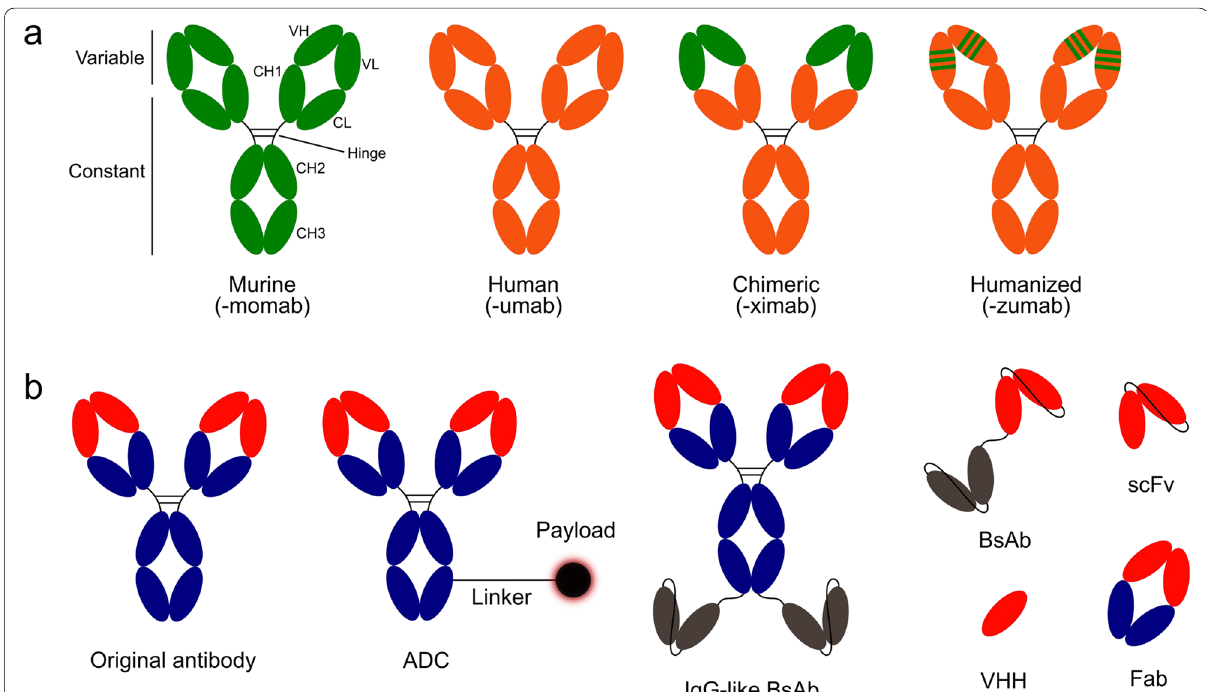
Fig. 5 Schematic overview of mAb, ADC, BsAb, and antibody fragments (Fab, scFv, VHH). a Antibody humanization from the murine antibody (green domain) to human antibody (orange domain) and associated suffixes. The chimeric mAb: the variable region is of murine origin, and the rest of the chain is of human origin. Humanized mAb: only includes the hypervariable segment of murine origin. CH: domains of the constant region of the heavy chain; CL: constant domain of the light chain; VH: variable domain of the heavy chain; VL: variable domain of the light chain. b Original antibody includes variable regions, also called VH and VL (red domain), and the constant region (blue domain). ADC comprises a mAb connected to a cytotoxic payload via an appropriate linker. BsAb consists of two linked antigen-binding fragments (red and gray domains) with two major formats: IgG-like BsAb and non-IgG-like BsAb; Fab consists of the light chain (VL CL) and the domains of the heavy chain (VH and CH1). scFv is + composed of the VH and VL joined by a short flexible polypeptide linker. VHH only contains one heavy chain variable